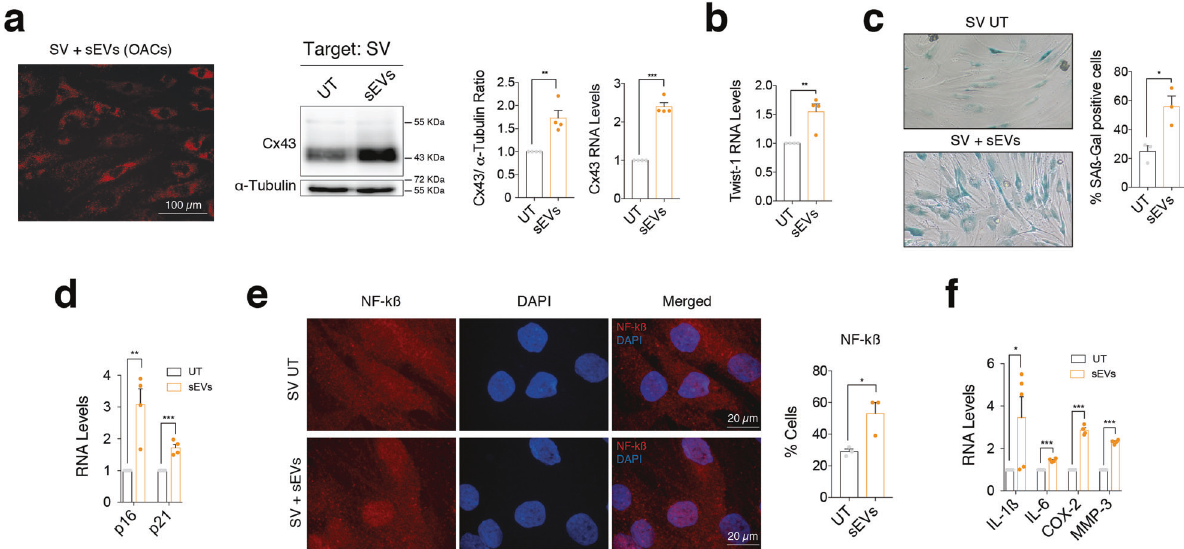
Fig. 8 sEVs derived by OA-derived chondrocytes promote in fl ammation and senescence in synovial cells. a Red Dil-labelled sEVs isolated from OA-derived chondrocytes were detected in synovial cells (SV) after 48-h treatment. Cx43 protein and RNA levels were upregulated in synovial cells (SV) treated with sEVs derived from OA-derived chondrocytes, as detected by western blot and RT-qPCR, respectively. n = 4; Student ’ s t test. b RNA levels of the EMT-transcription factor Twist-1 were signi fi cantly upregulated in synovial cells after a 48-h treatment with sEVs isolated from OA-derived chondrocytes. n = 4, Student ’ s t test. c Senescence-associated β -galactosidase activity (SA- β -Gal) levels were upregulated synovial cells treated for 48 h with sEVs derived from OA-derived chondrocytes. n = 3, Student ’ s t test. d The gene expression levels of the senescence markers p16 and p21 were upregulated in SV after a 48-h treatment with sEVs derived from OA-derived chondrocytes. n = 4, Student ’ s t test. e Treatment of synovial cells (SV) with sEVs isolated from OA-derived chondrocytes promoted NF-k β nuclear translocation, as detected by immuno fl uorescence. n = 3, Student ’ s t test. f Overexpression of SASP factors IL-1 β , IL-6, COX-2 and MMP-3 in SV treated for 48 h with sEVs isolated from OA-derived chondrocytes. n = 4 – 5, Student ’ s t test. Data are expressed as mean ± S.E.M., * P < 0.05, ** P < 0.01, *** P <